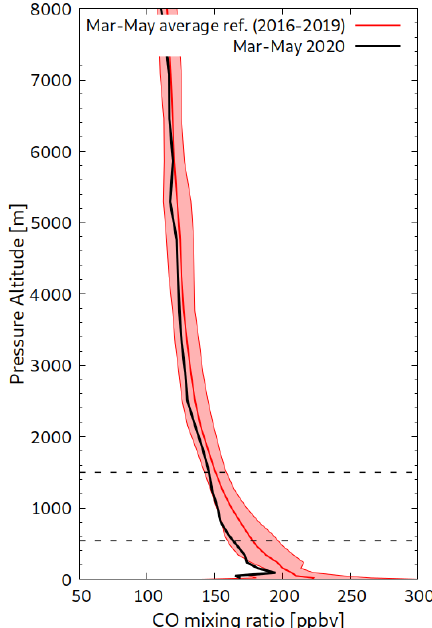
Figure 8. IAGOS observations of CO for March–April–May (MAM) 2020 in black. In red, the average profile for MAM cal- culated over the reference period of 2016–2019 (300 profiles). The shaded area represents the interannual variability for MAM over this reference period. Horizontal lines denote the boundaries of the sections of study as used in subsequent